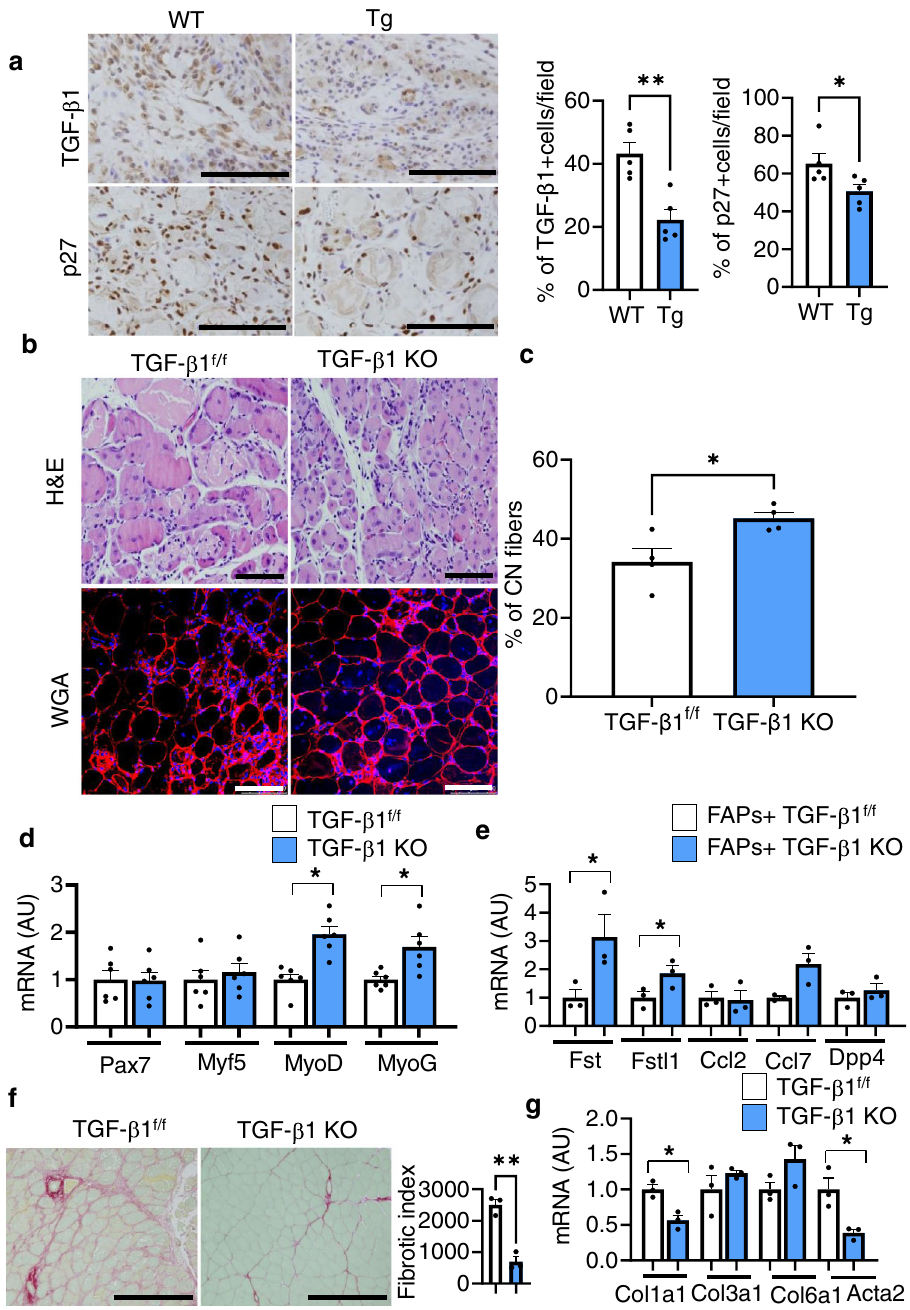
Fig.4|DepletionofCD206 + M2-likeM Φ reducesTGF- β signalingandimproves muscle recovery. a Representative images of paraf fi n sections of muscle from Tg mice and their littermate control WT mice following acute injury(7dpi). Scale bar, 200 μ m, 20×. Quanti fi cation of TGF- β 1 + , and p27 + cells/ fi eld is given in right panel ( n =5 mice per group). b Histological sections of gastrocnemius muscle from CD206 + M2-like M Φ -derived TGF- β 1 KO and TGF- β 1 f/f mice, harvested at 7 dpi, stained with H&E (upper) or WGA and DAPI (lower) ( n =4 mice per group). Scale bar, 200 μ m (H&E) and 100 μ m (WGA). c Quanti fi cation of CN myo fi bers of the gastrocnemius muscle ( n =4 mice per group). d Relative mRNA expression of myogenesis-related marker genes in the muscle of TGF- β 1 KO mice compared to TGF- β 1 f/f littermate control mice ( n =6 mice per group). e Relative mRNA expres- sion of activated FAP-related marker genes in FACS-isolated FAPs of TGF- β 1 KO